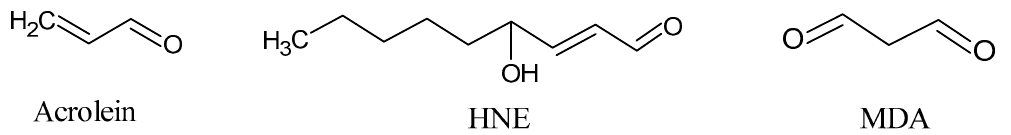
Figure 5. Short-chain aldehydes: acrolein, 4-hydroxy-2-hexenal (HNE), and malondialdehyde